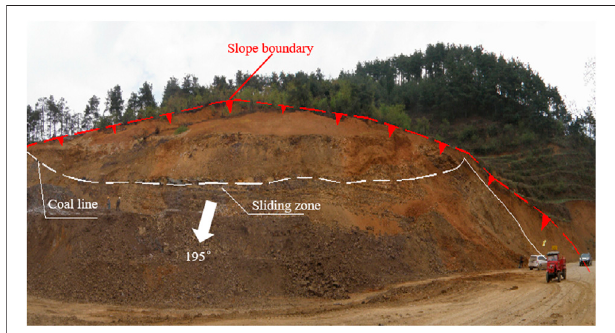
Frontiers in Earth Science |